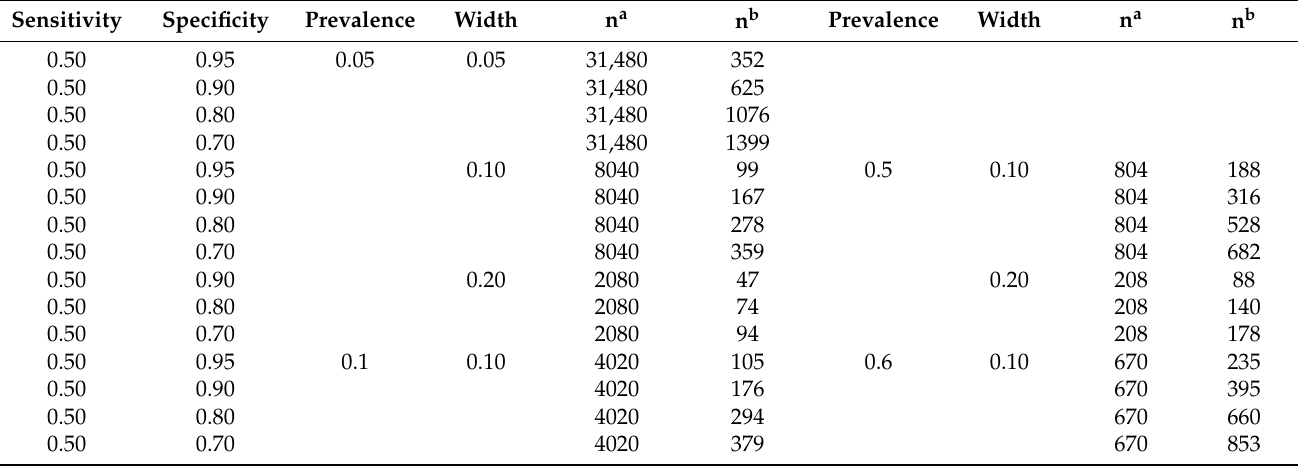
Table 4. Recommended sample size requirements involving research for a screening purpose that emphasizes a degree of specificity that is based on its 95% confidence